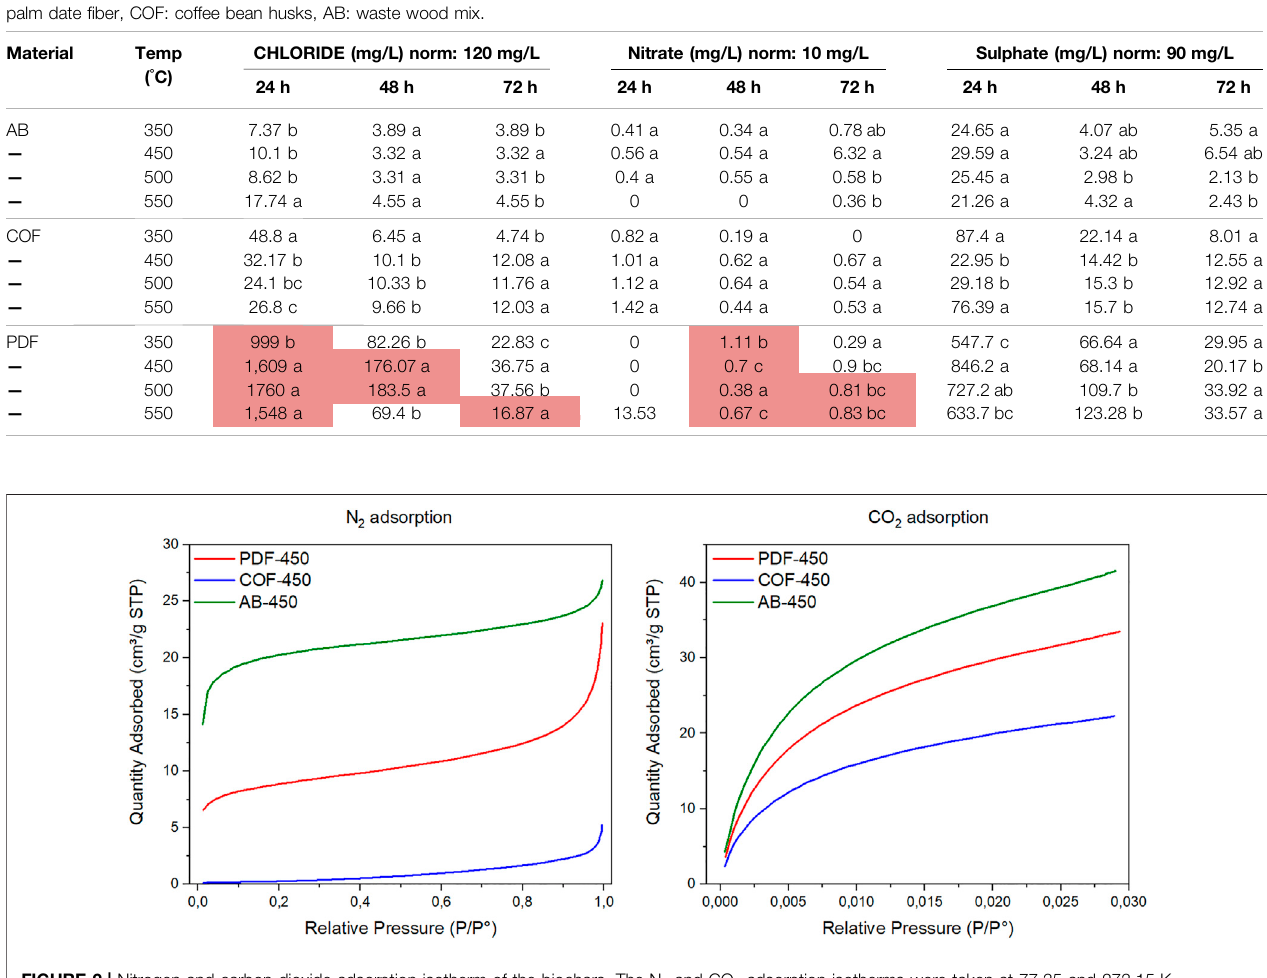
Frontiers in Environmental Science |